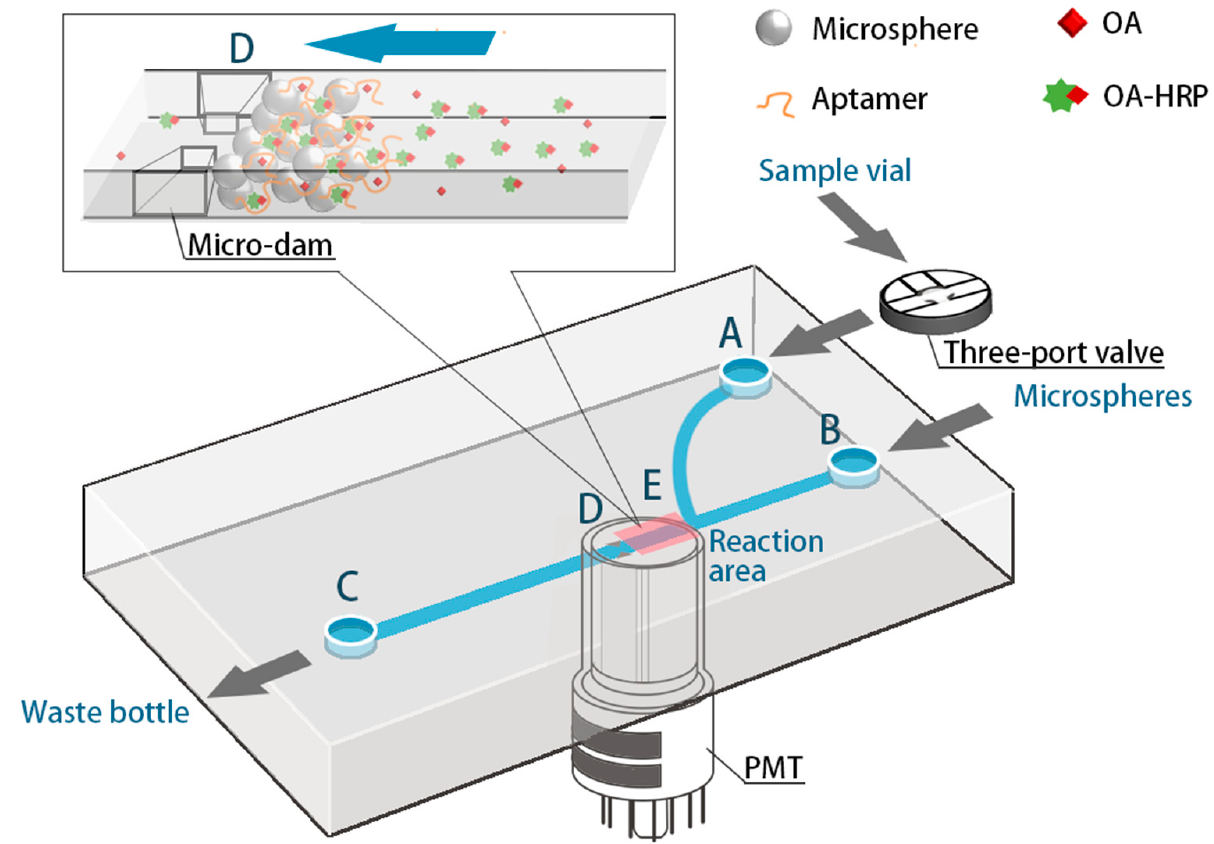
Figure 2. Diagram of the microfluidic device with a partially enlarged view in the reaction area.